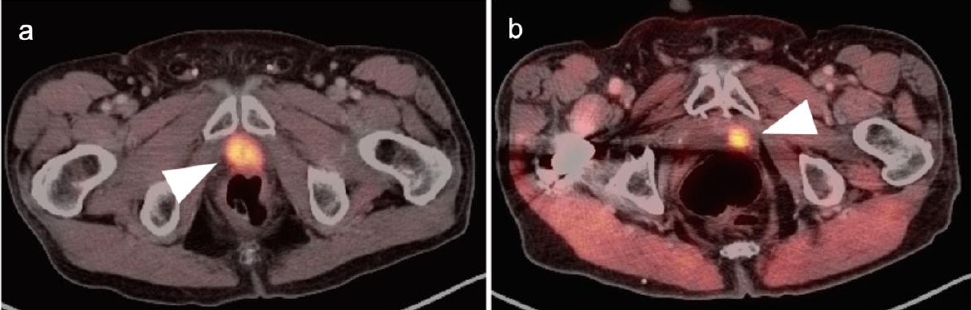
Figure 22. Two patients with prostate cancer recurrence in the post-surgical prostatic fossa, clearly delineated by [ 18 F]-fluciclovine PET-CT. ( a , b ) The prostate cancer recurrence is intensely PET-positive in both cases (white arrowheads).